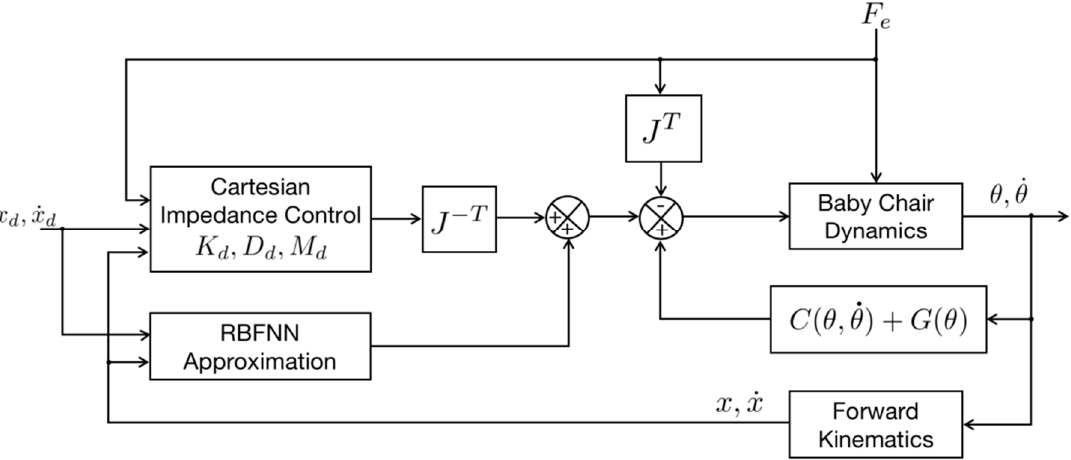
Figure 14. The control diagram of the neural approximation-enhanced Cartesian impedance control.